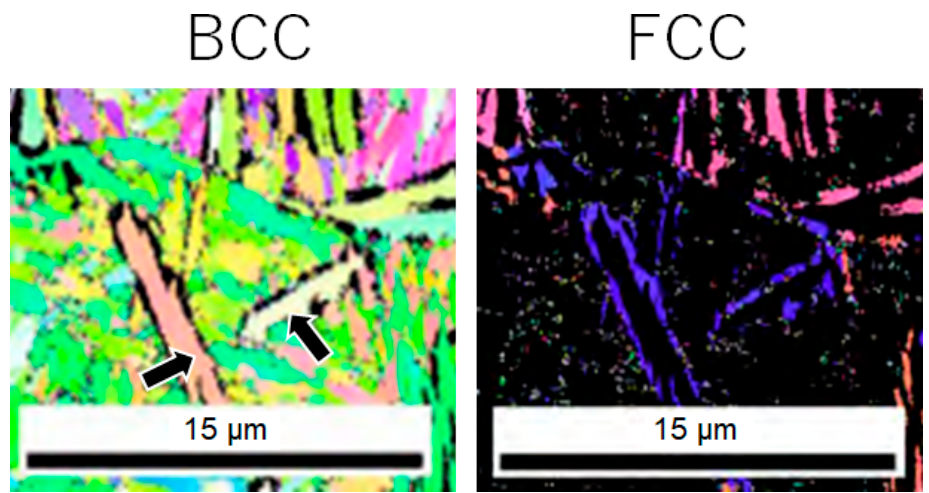
Figure 10. EBSD orientation maps for BCC (ferrite/martensite) and FCC (retained austenite) for the sample after isothermal heating at 673 K for 100 s. The arrows indicate bainitic ferrite sheaves. As clearly seen here, the isolated sheaf is surrounded by the retained austenite layer.